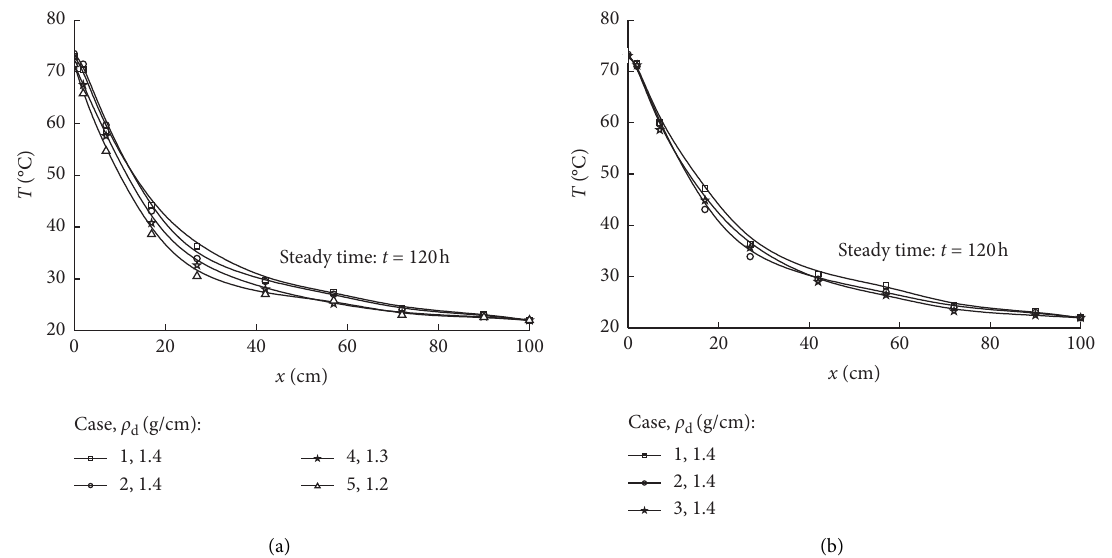
Figure 3: Steady-state temperature distribution along the distance: (a) effect of the dry density and (b) effect of the placement